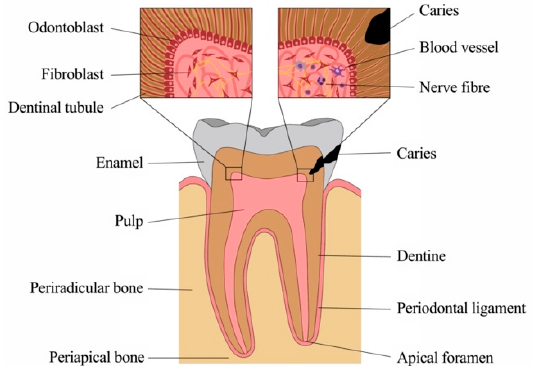
Figure 1. Anatomy and physiology of the tooth.